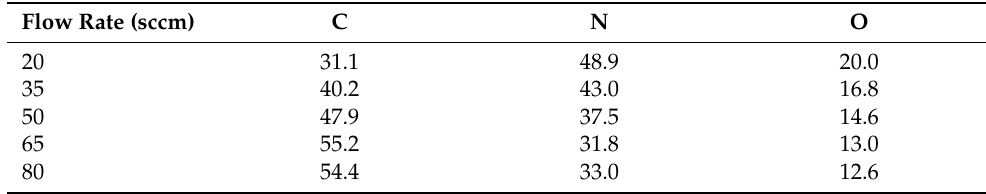
Table 1. The elemental composition of films deposited at different monomer flow rates. The elemental composition is given in atomic